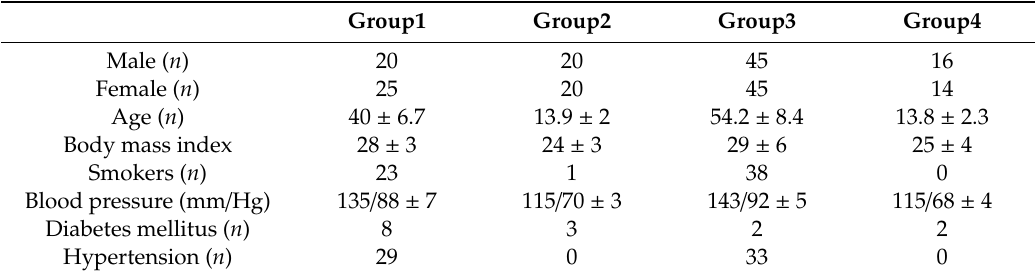
Table 1. Demographics of migraine patients (Group 1: > 18 years old; Group 2: < 18 years old) and controls of healthy subjects (Group 3: > 18 years old; Group 4: < 18 years old) enclosed in this study. Data are expressed as mean ± standard deviation